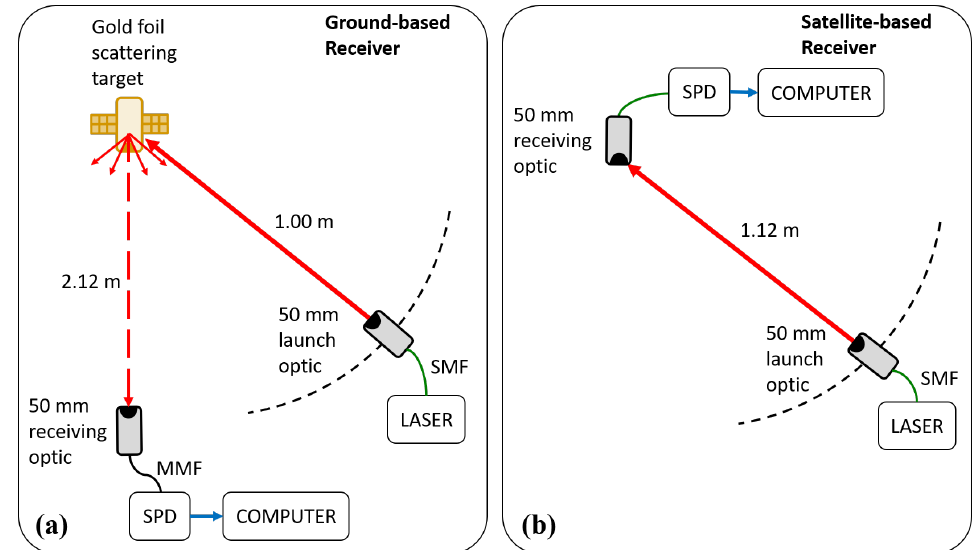
Figure 1. Simplified schematic of the setup to determine the optical scattering profile of a wrinkled gold foil target. Setup ( a ) simulates the scenario where light from the laser terminal scatters from the satellite and is detected by the QKD ground station, while setup ( b ) simulates the scenario where light from the laser terminal is detected by a satellite-based QKD receiver due to photons entering the receiving optic highly off-axis and scattering internally. SPD, single photon